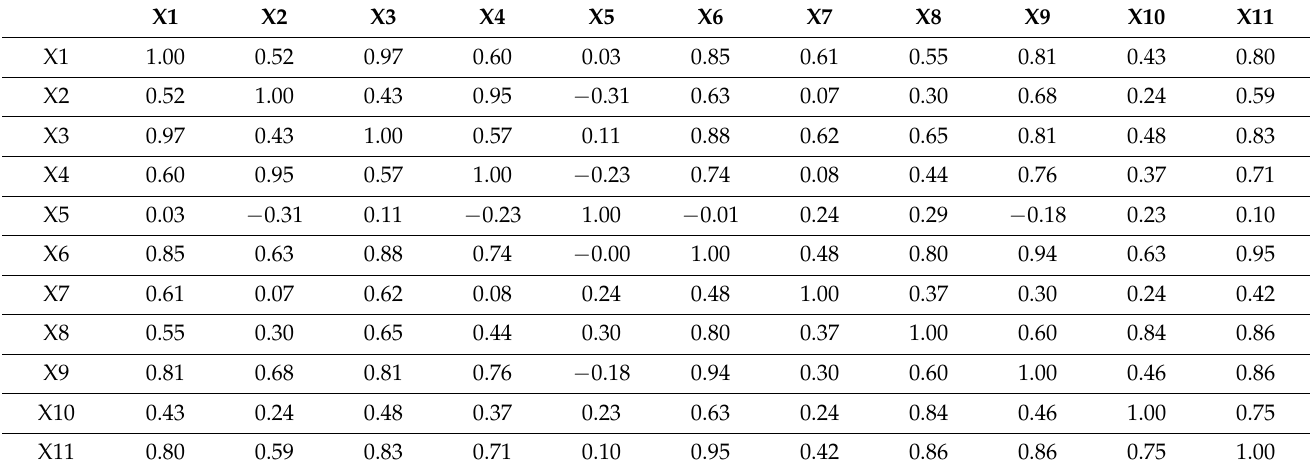
Table 6. Correlation matrix for 2013.